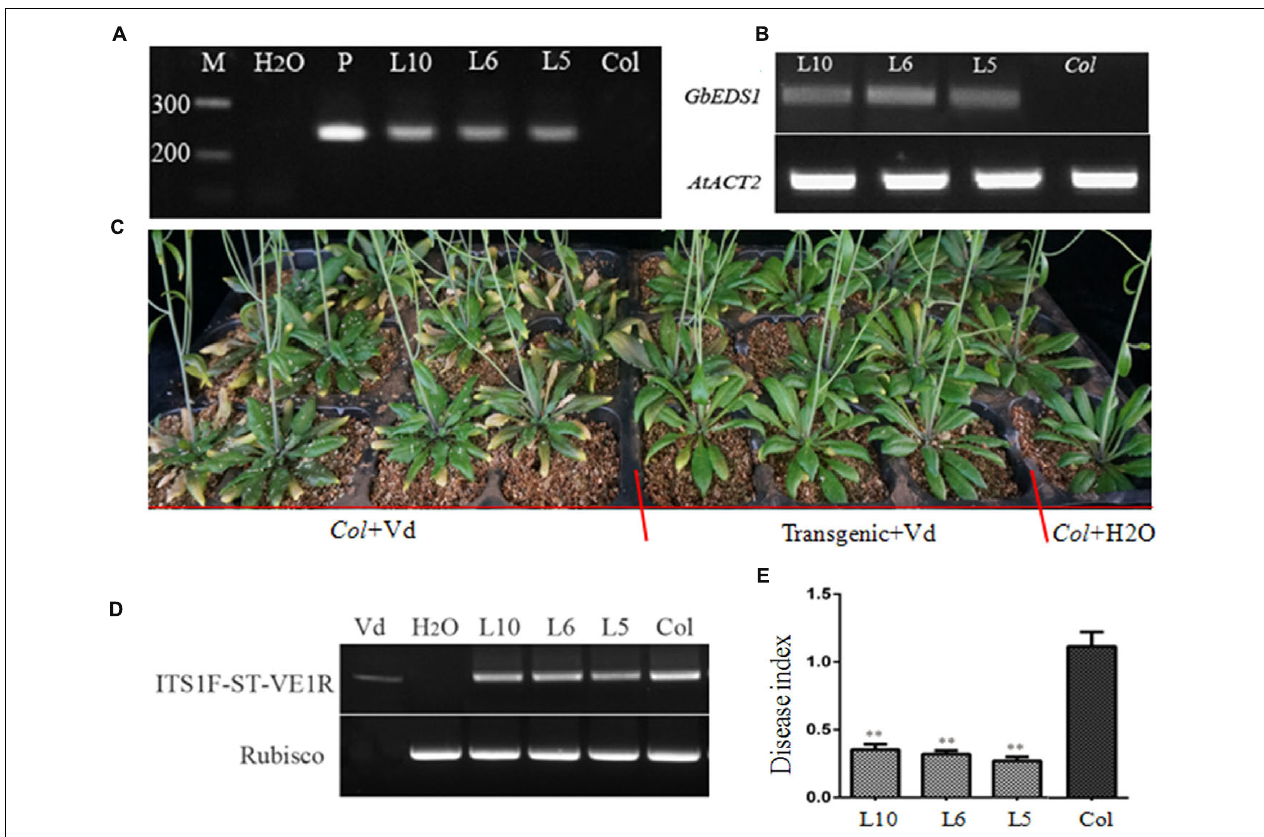
FIGURE 5 | Overexpression of GbEDS1 in Arabidopsis improved the resistance to V. dahliae . (A) Direct-PCR analysis of genomic DNA from transgenic lines. (B) RT-PCR analysis the expression of GbEDS1 gene in transgenic lines and wilt type plants. M: Marker, H 2 O represented negative control in the PCR system. (C) Four-week-old plants were inoculated via root-dipping with 5 × 10 7 conidia mL − 1 . Similar results were seen from all transgenic lines. Transgenic and wild type plants showed obvious differences in resistance, transgenic plants showed more resistant than wild type plants. (D) Detection the biomass of the V. dahliae in the transgenic plant with RT-PCR by comparing V. dahliae internal transcribed spacer (ITS) transcript levels (as a measure for fungal biomass) relative to Arabidopsis Rubisco transcript levels (for equilibration) at 14 days post-inoculation. (E) Detection the biomass of the V. dahliae in the transgenic plant with Quantitative real-time PCR. The relative average fungal biomass is shown with standard errors. Asterisks indicate significant differences when compared with colonization of the eds1 mutant. The average fungal biomass was determined using at least three inoculated plants for each genotype. ( ∗∗ P < 0.01).